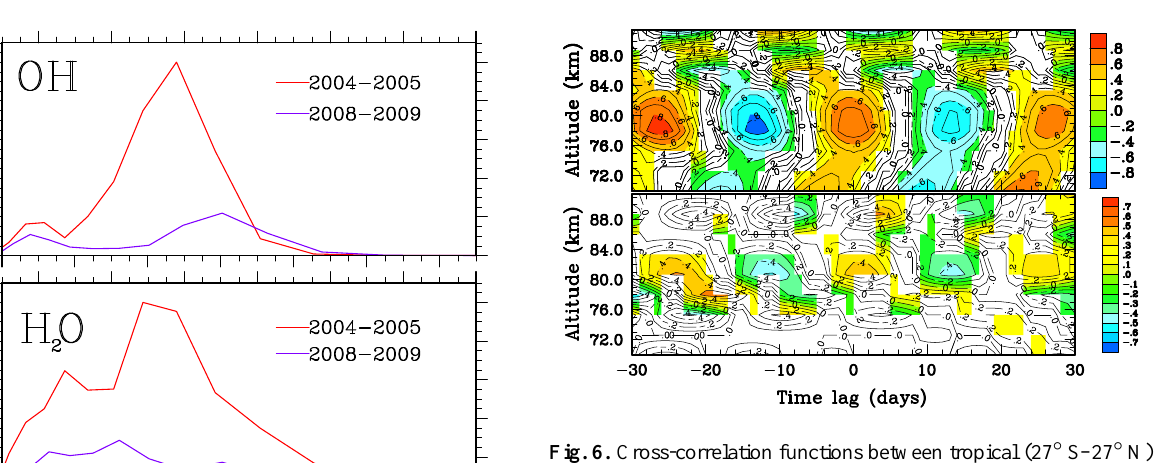
Fig. 6. Cross-correlation functions between tropical (27 ◦ S–27 ◦ N) mesospheric OH and SOLSTICE/SORCE Ly- α irradiance as func- tion of altitude and response time-lag. Daytime OH for the solar “max” (top panel) and “min” (bottom panel)”. Colored areas: sig- nificance ≥